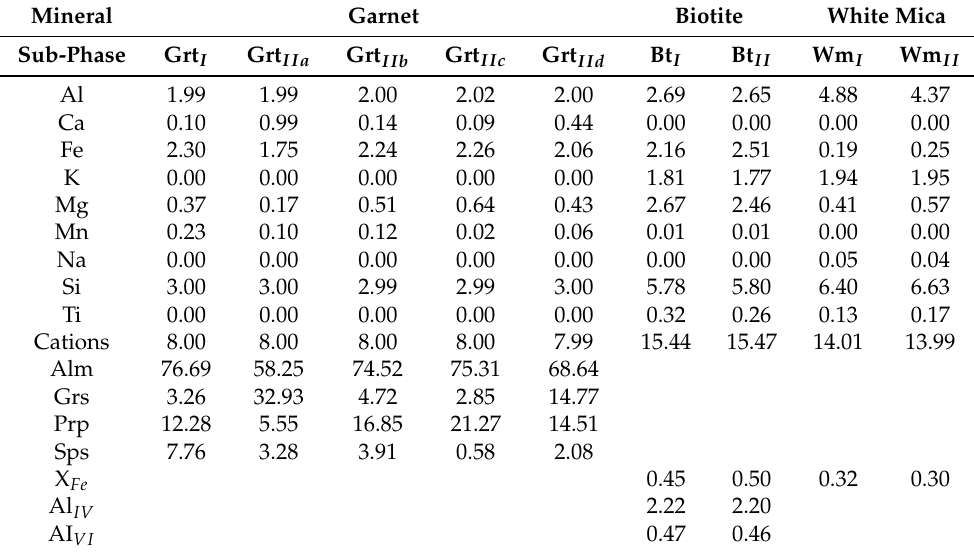
Table 3. Average compositions of minerals from Monte Mucrone obtained via Q-XRMA. All val- ues are calculated on the base of 63,404 calibrated pixels for Grt I ; 879 calibrated pixels for Grt IIa ; 14,265 calibrated pixels for Grt IIb ; 41,557 calibrated pixels for Grt IIc and 5085 calibrated pixels for Grt IId ; 1694 calibrated pixels for Bt I and 1478 calibrated pixels for Bt II ; 49,492 calibrated pixels for Wm I and 41,644 calibrated pixels for Wm II . Mineral Garnet Biotite White Mica